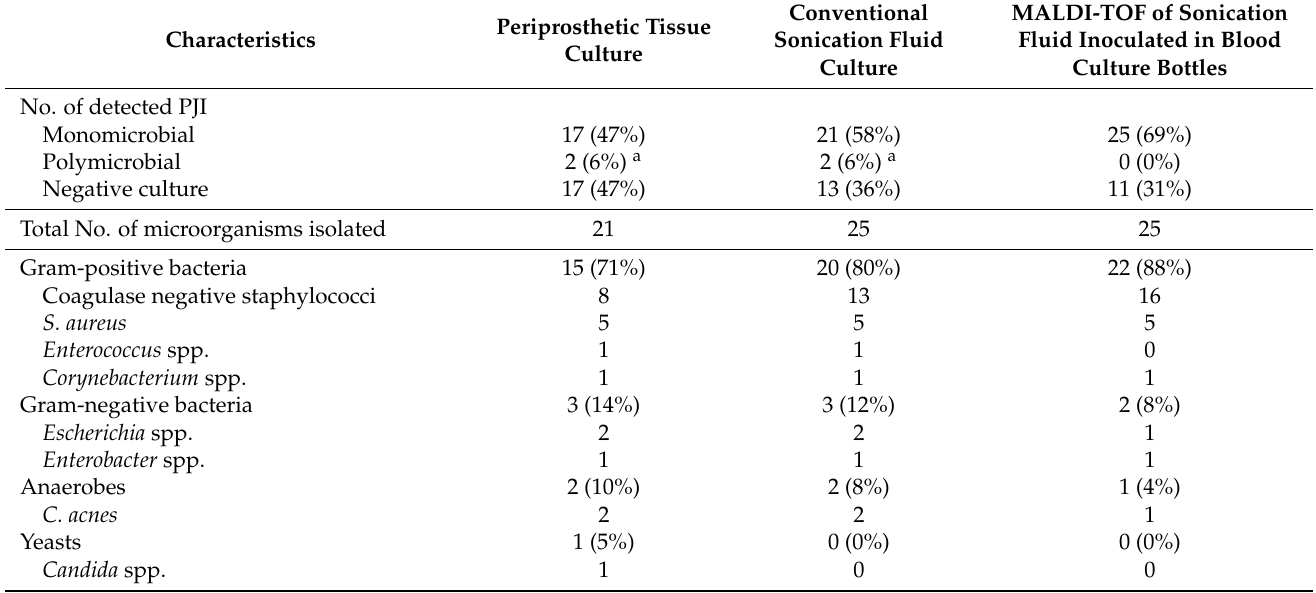
Table 1. Microbiological findings in 36 PJI cases according to type of diagnostic method.